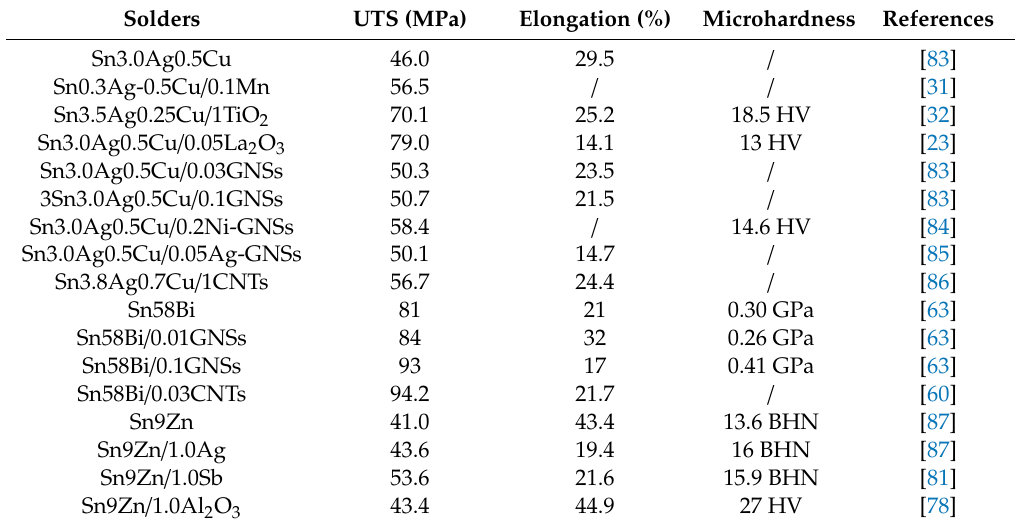
Table 2. The mechanical properties of nanoparticle-reinforced lead-free